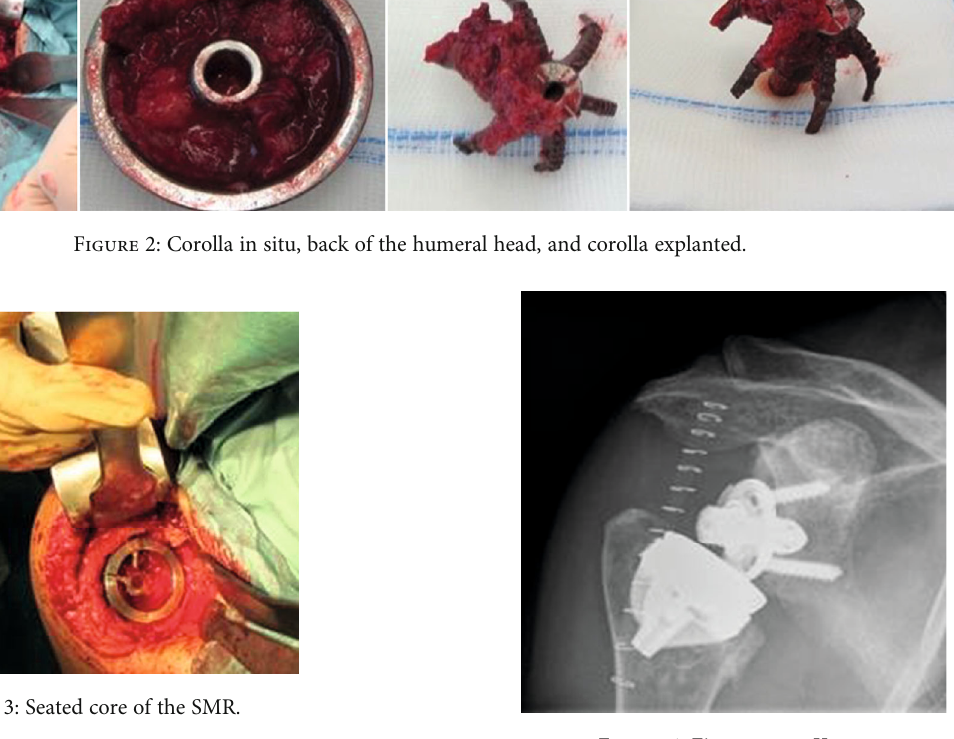
Figure 4: First post-op